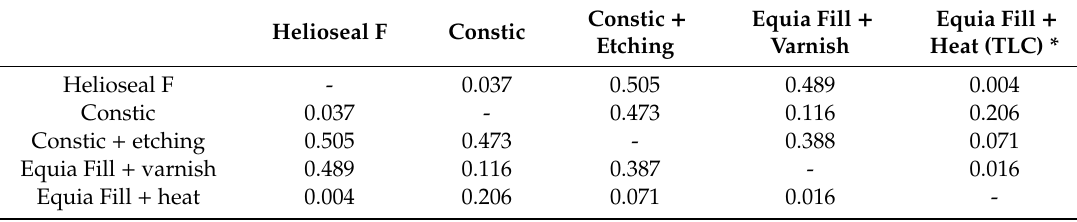
Table 2. Mann–Whitney U Test Post-hoc analysis of multiple comparisons of di ff erent